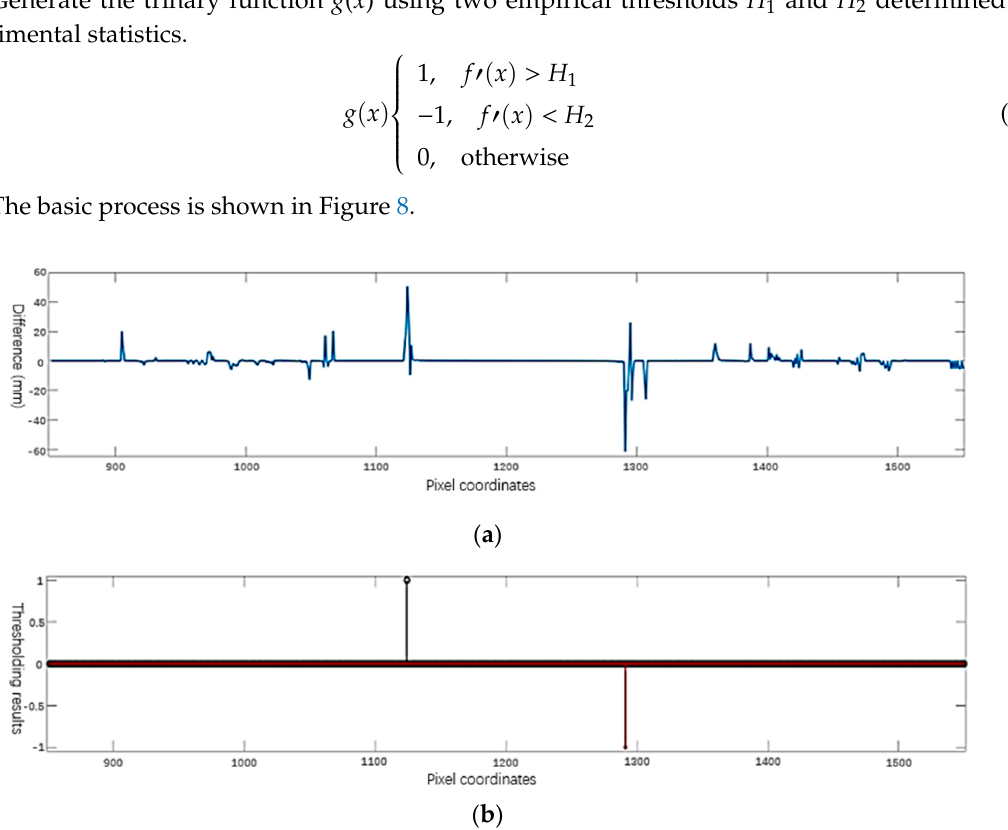
Figure 9. Nut positioning result.